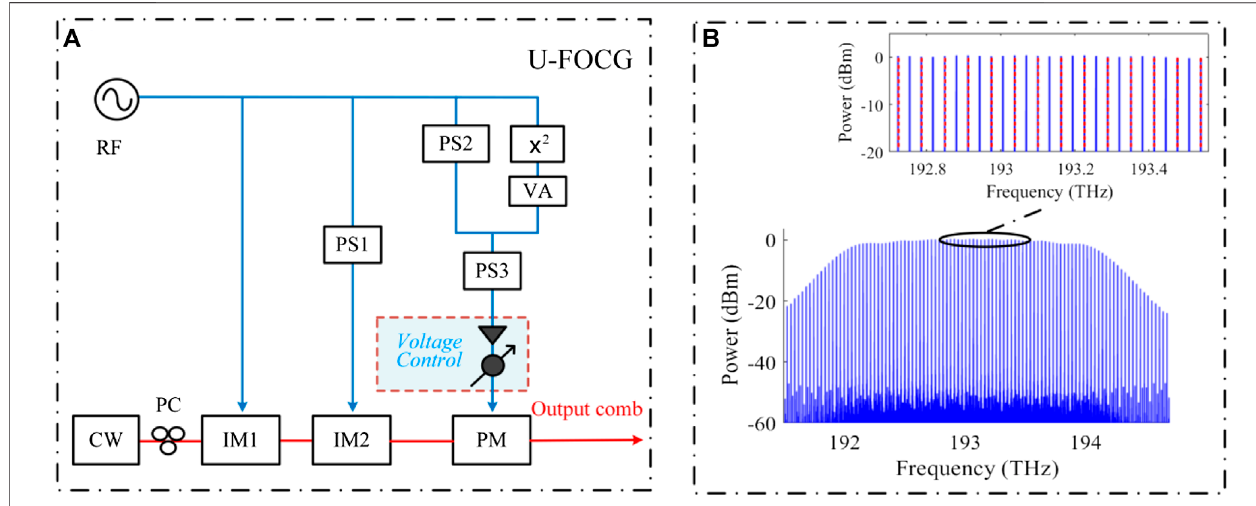
FIGURE 5 | (A) Schematic diagram of the ultra- fl at optical comb generator (U-FOCG), (B) Spectra of the output of the U-FOCG with 4-dB gain, and the employed 14 optical comb lines with about 0 dBm optical powers. CW, continuous-wave laser; PC, polarization controller; IM, intensity modulator; PS, phase shifter; PM, phase modulator; x 2 , x 2 frequency multiplier; VA, variable